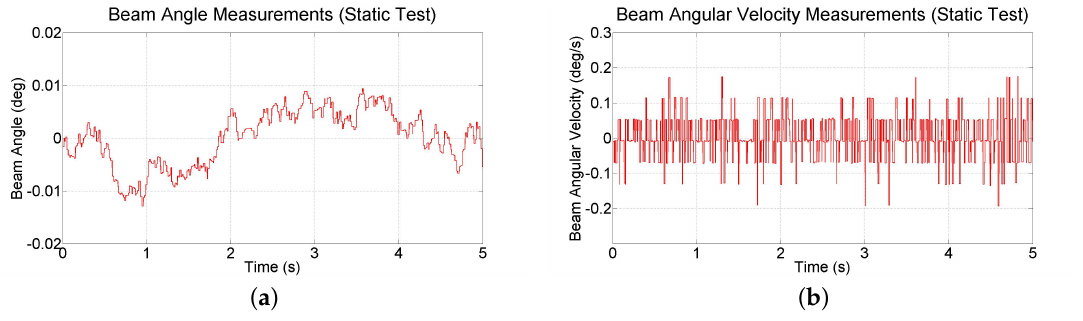
Figure 16. Measurements of ( a ) beam angle and ( b ) angular velocity collected during a static test.